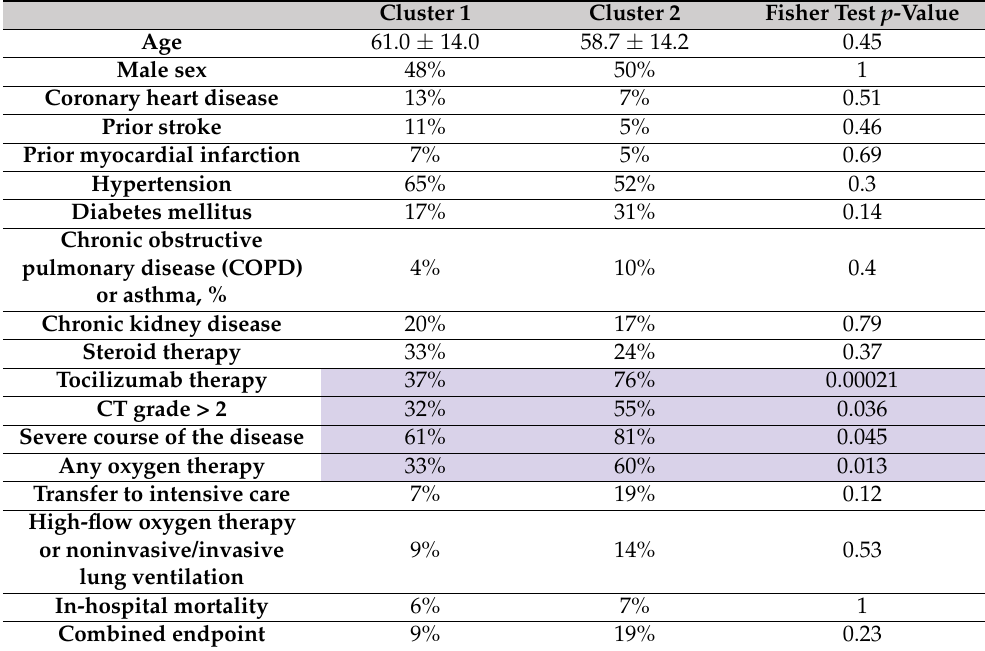
Table 1. Comparison of clinical parameters and outcomes between patient cytokine clusters. p -values are presented according to the Fisher exact test. Cluster 1 Cluster 2 Fisher Test p -Value Age 61.0 ±